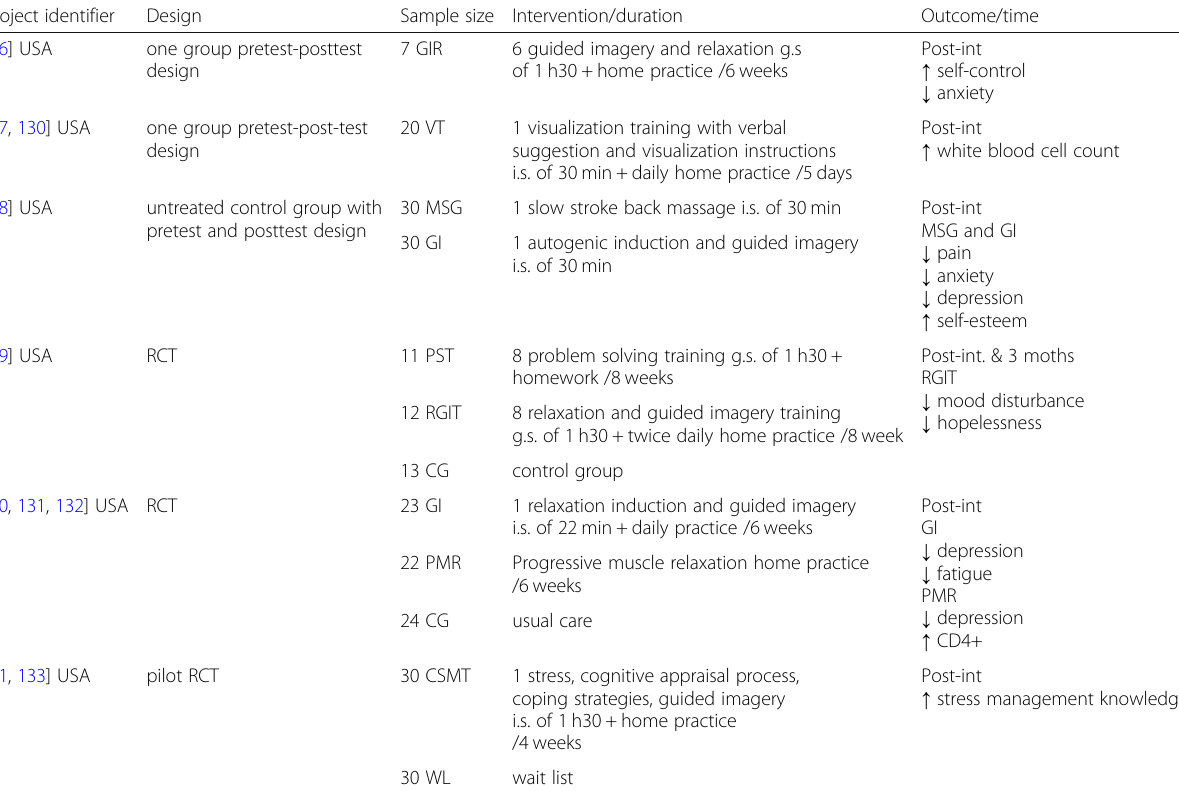
Table 8 Guided imagery included studies Project